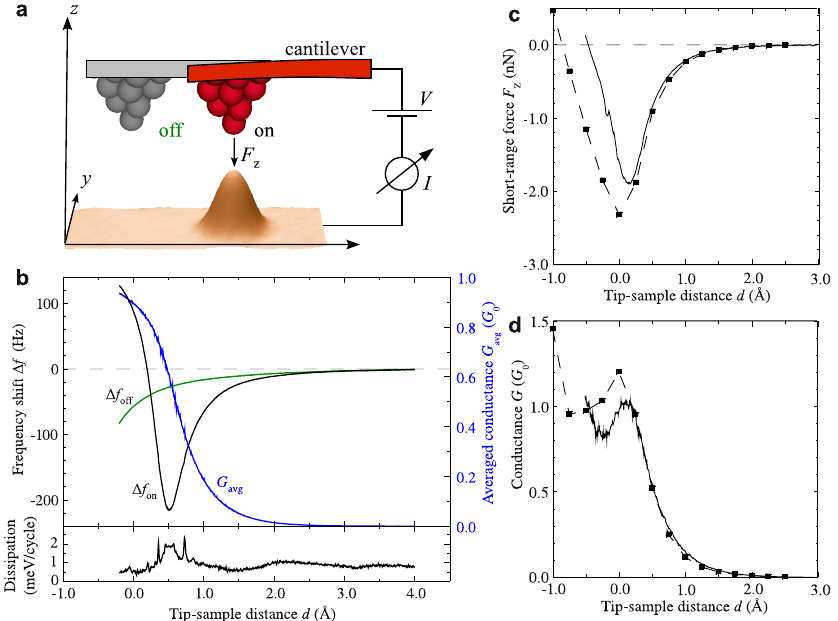
Figure 9. ( a ) 3D representation of a constant current STM image ( I = 1nA, V = 1mV, 4 × 5 nm 2 ) of a single Pt atom adsorbed on a Pt(111) surface and a schematic of the probing tip. ( b ) Time-average junction conductance G av = I av / V (blue dashed curve) and frequency shift ∆ f on top (black curve) and off (green curve) the Pt atom measured at different tip–sample distances d . The lower panel shows the dissipation signal D on top of the Pt atom recorded simultaneously with G av and ∆ f . ( c ) Calculated short-range force between tip apex and Pt adatom (full line) and simulated forces (squares) from data in ( b ). ( d ) Conductance after deconvolution of the tip oscillation (full line) and simulated conductance (squares). All conductances are given in units of the single–channel, spin–degenerate quantum of conductance G 0 = 2 e 2 / h ≈ ( 12906 Ω ) − 1 where e is the elementary charge and h is Planck’s constant. Adapted with permission from American Physical Society from Figure 1 in